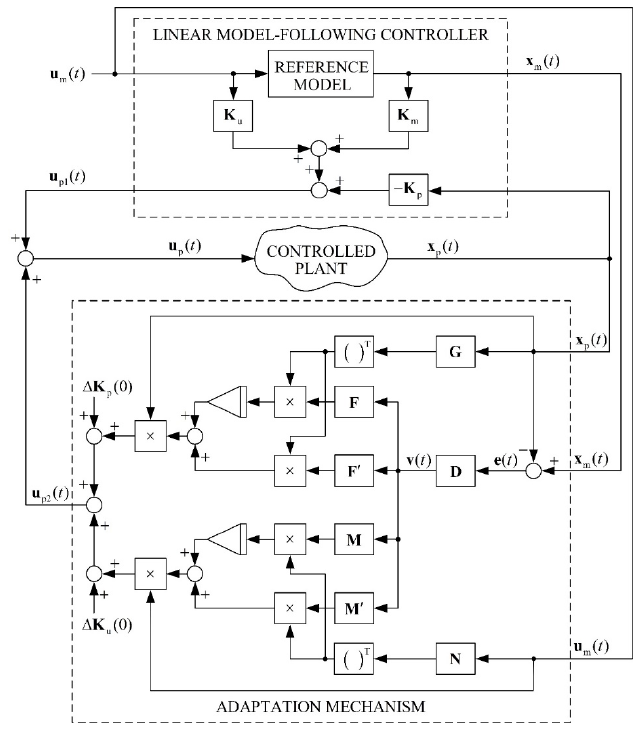
Figure 4. Block diagram of an adaptive model-following control system.